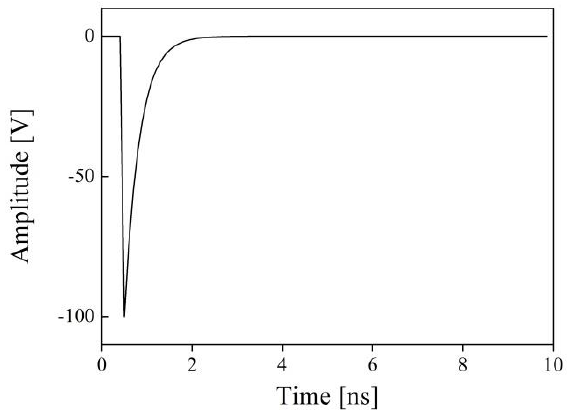
Figure 7. Simulated excitation pulse used in the KLM model modified for the through-transmission method.